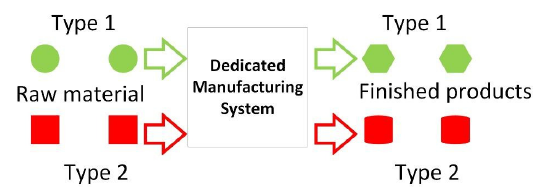
Fig. 1: DMS designed for multiple products